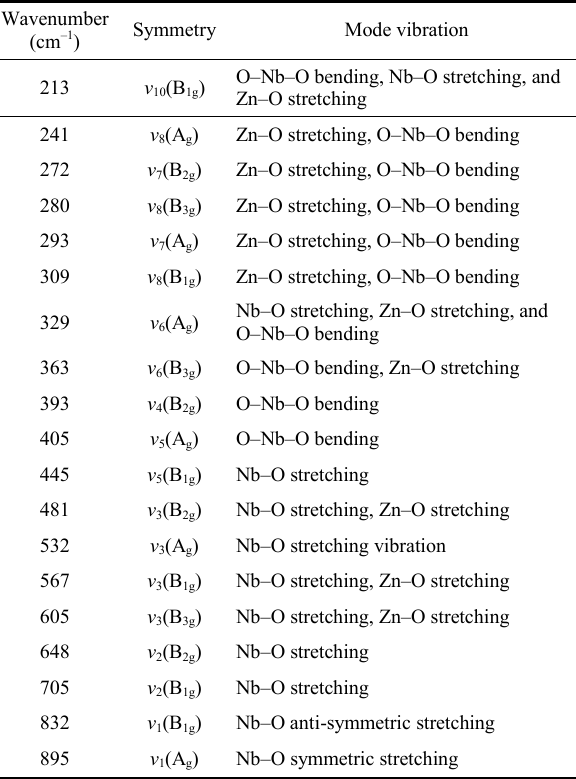
Raman vibrational mode assignments for ZnNb 2 O 6